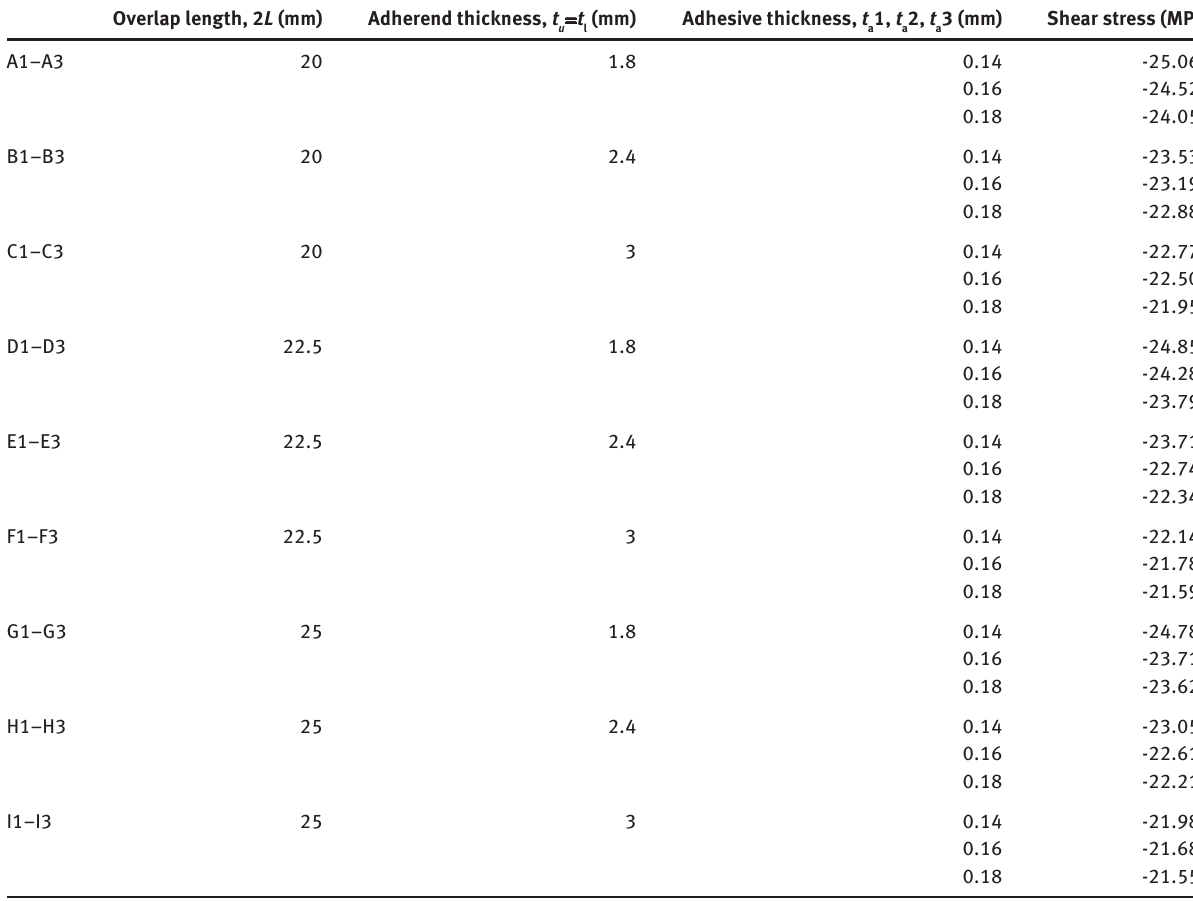
Table 8 The maximum shear stress in the elastoplastic model. Overlap length, 2 L